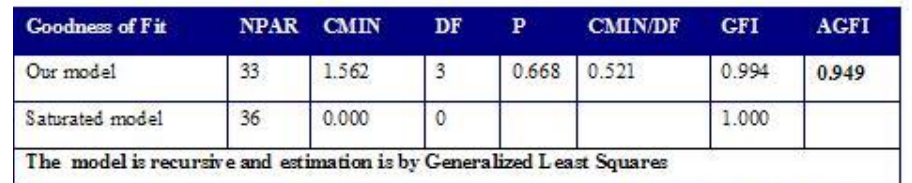
Table 5. Goodness-of-fit